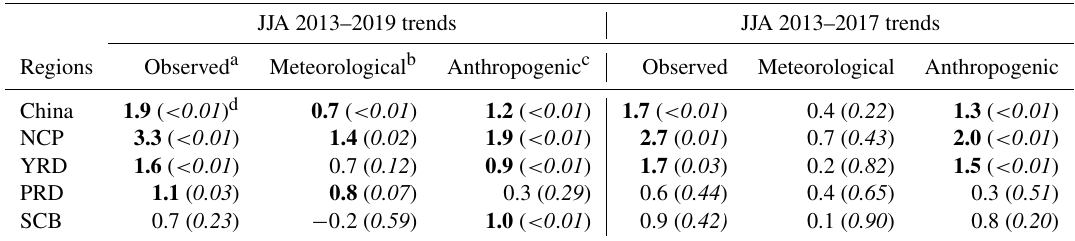
Regions Observed a Meteorological b Anthropogenic c